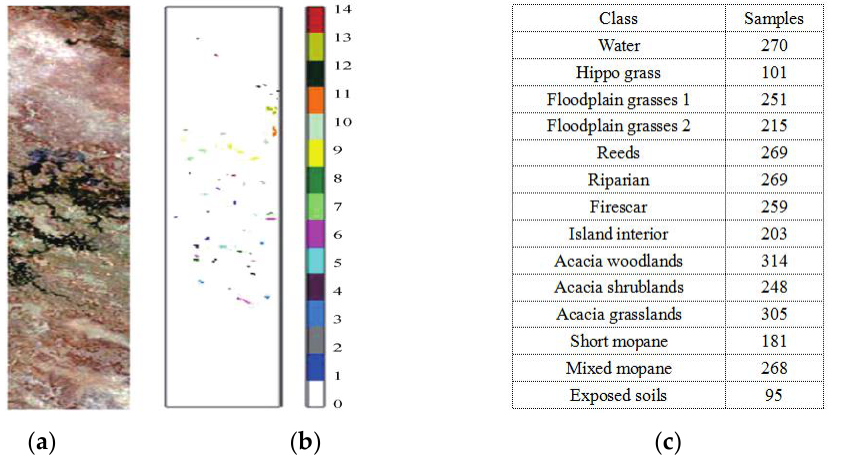
Figure 7. Botswana data set ( a ) false color images ( b ) corresponding ground object types ( c ) number of sample sets.